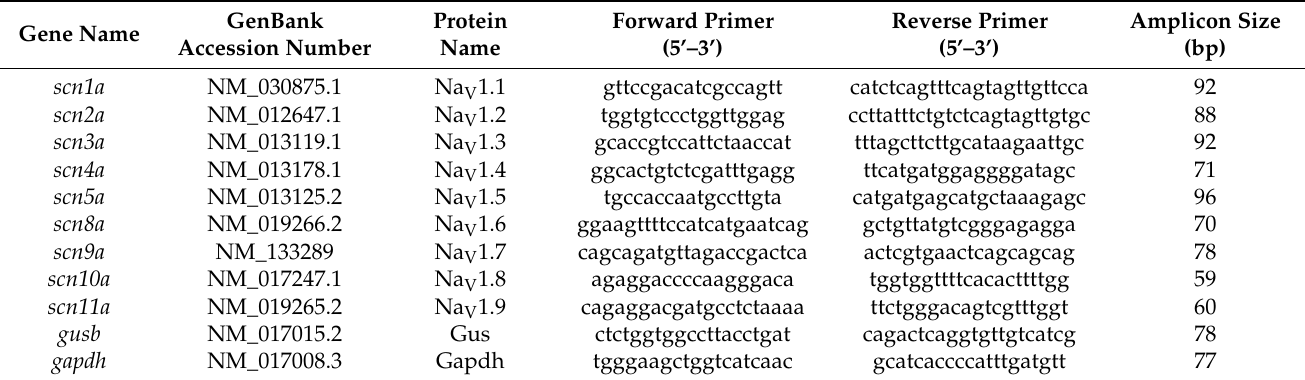
Table 4. Primers pairs used to amplify Nav channel transcripts by